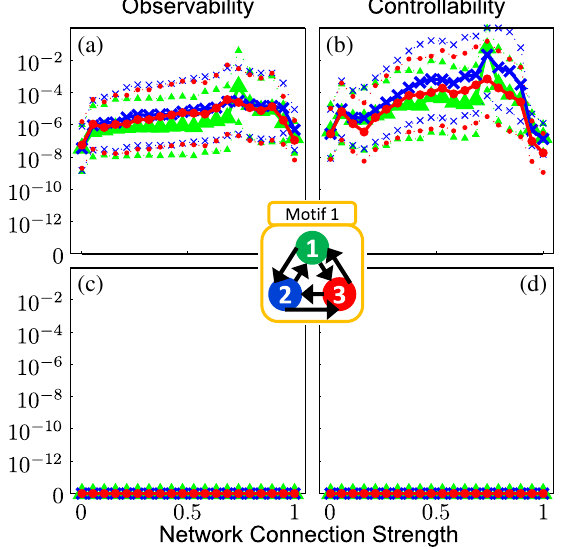
FIG. 2. Calculation of (a),(c) observability and (b),(d) control- lability indices for motif 1 for a chaotic dynamical regime, as measured from each node (green triangles, 1; blue crosses, 2; red dots, 3). The thick lines and symbols mark the mean values of each distribution of indices for each coupling strength, while the smaller symbols and dotted lines represent the (cid:4) 1 standard deviation confidence intervals. Plots in the top row represent the results computed with symmetry-breaking heterogeneous cou- plings while plots in the bottom row are those with identical coupling strengths.